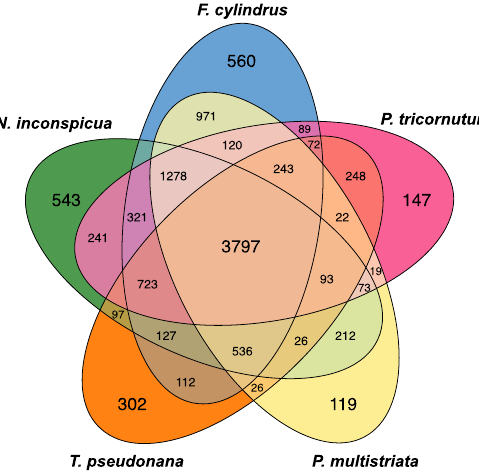
Figure 6. Orthologous protein families in N. inconspicua versus other diatom genomes. Allelic duplicates and low-complexity repeat regions were removed from N. inconspicua before clustering, leaving 17,968 haploid representatives. Numbers indicate protein families with at least two members, excluding "singletons" that have no orthologous or paralogous matches. Accession numbers associated with each family are provided in Supplementary Dataset 1, obtained from the PhycoCosm haploid gene catalog 86 for N. inconspicua,